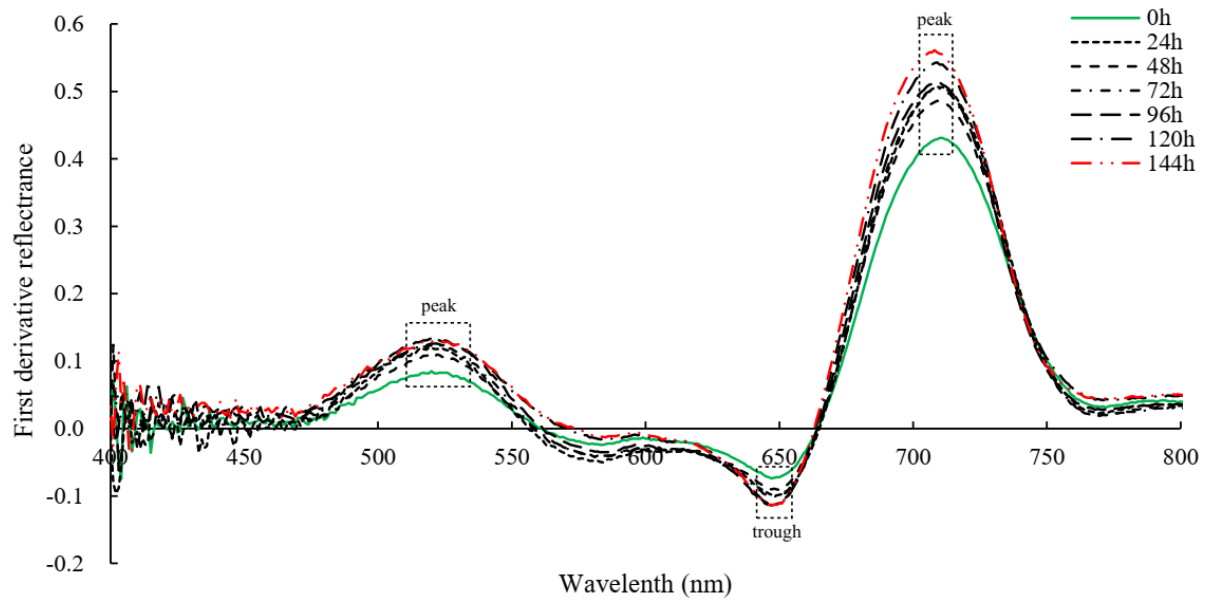
Figure 12. Spectral analysis in VIS under different moisture